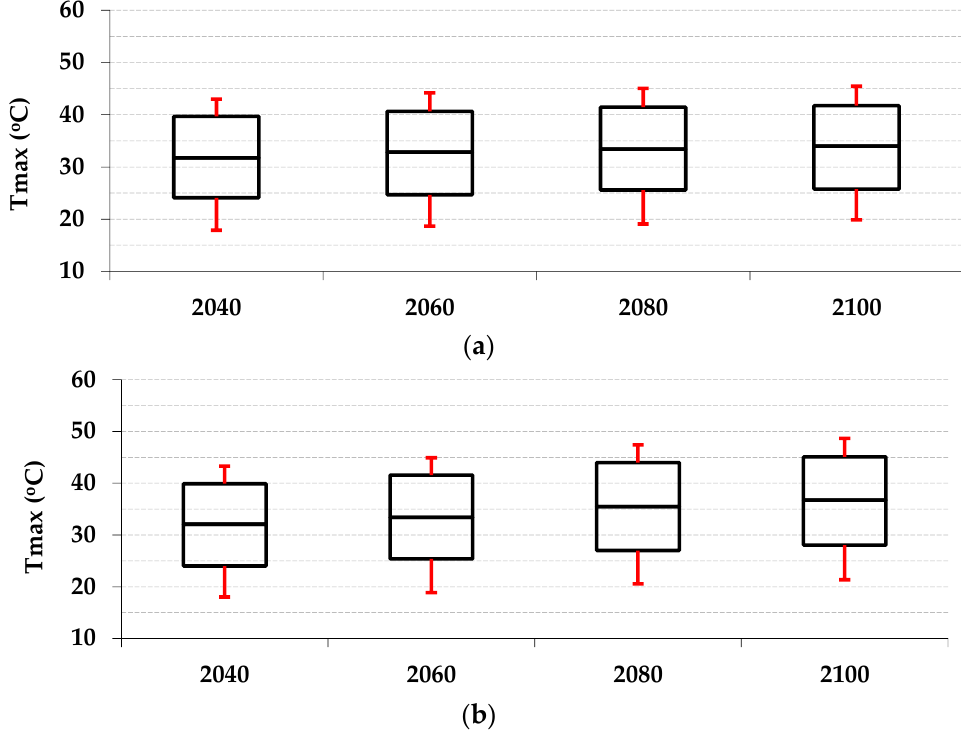
Figure 8. Box Plot of annual Tmax for four climate models under ( a ) SSP2-4.5 and ( b ) SSP5-8.5.